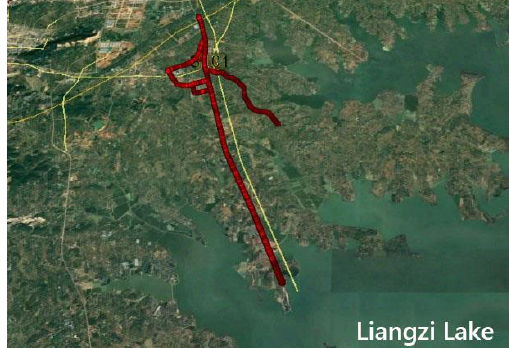
Figure 7. Experimental scene of the dynamic vehicle data.